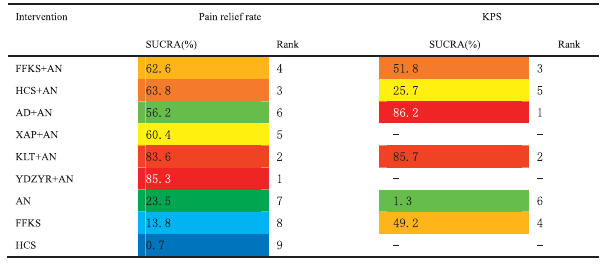
Note: The warmer the color, the greater the SUCRA, and the greater the probability of becomingthe bestintervention. FFKS + AN, Fufangkushen injection+ analgesic;HCS + AN, Huachansu injection + analgesic; AD + AN, Aidi injection + analgesic; XAP + AN, Xiaoaipinginjection+analgesic;KLT+AN,Kanglaiteinjection+analgesic;YDZYR+AN, Yadanziyouru injection + analgesic; AN, analgesic; FFKS, fufangkushen injection; HCS, huachansu injection.